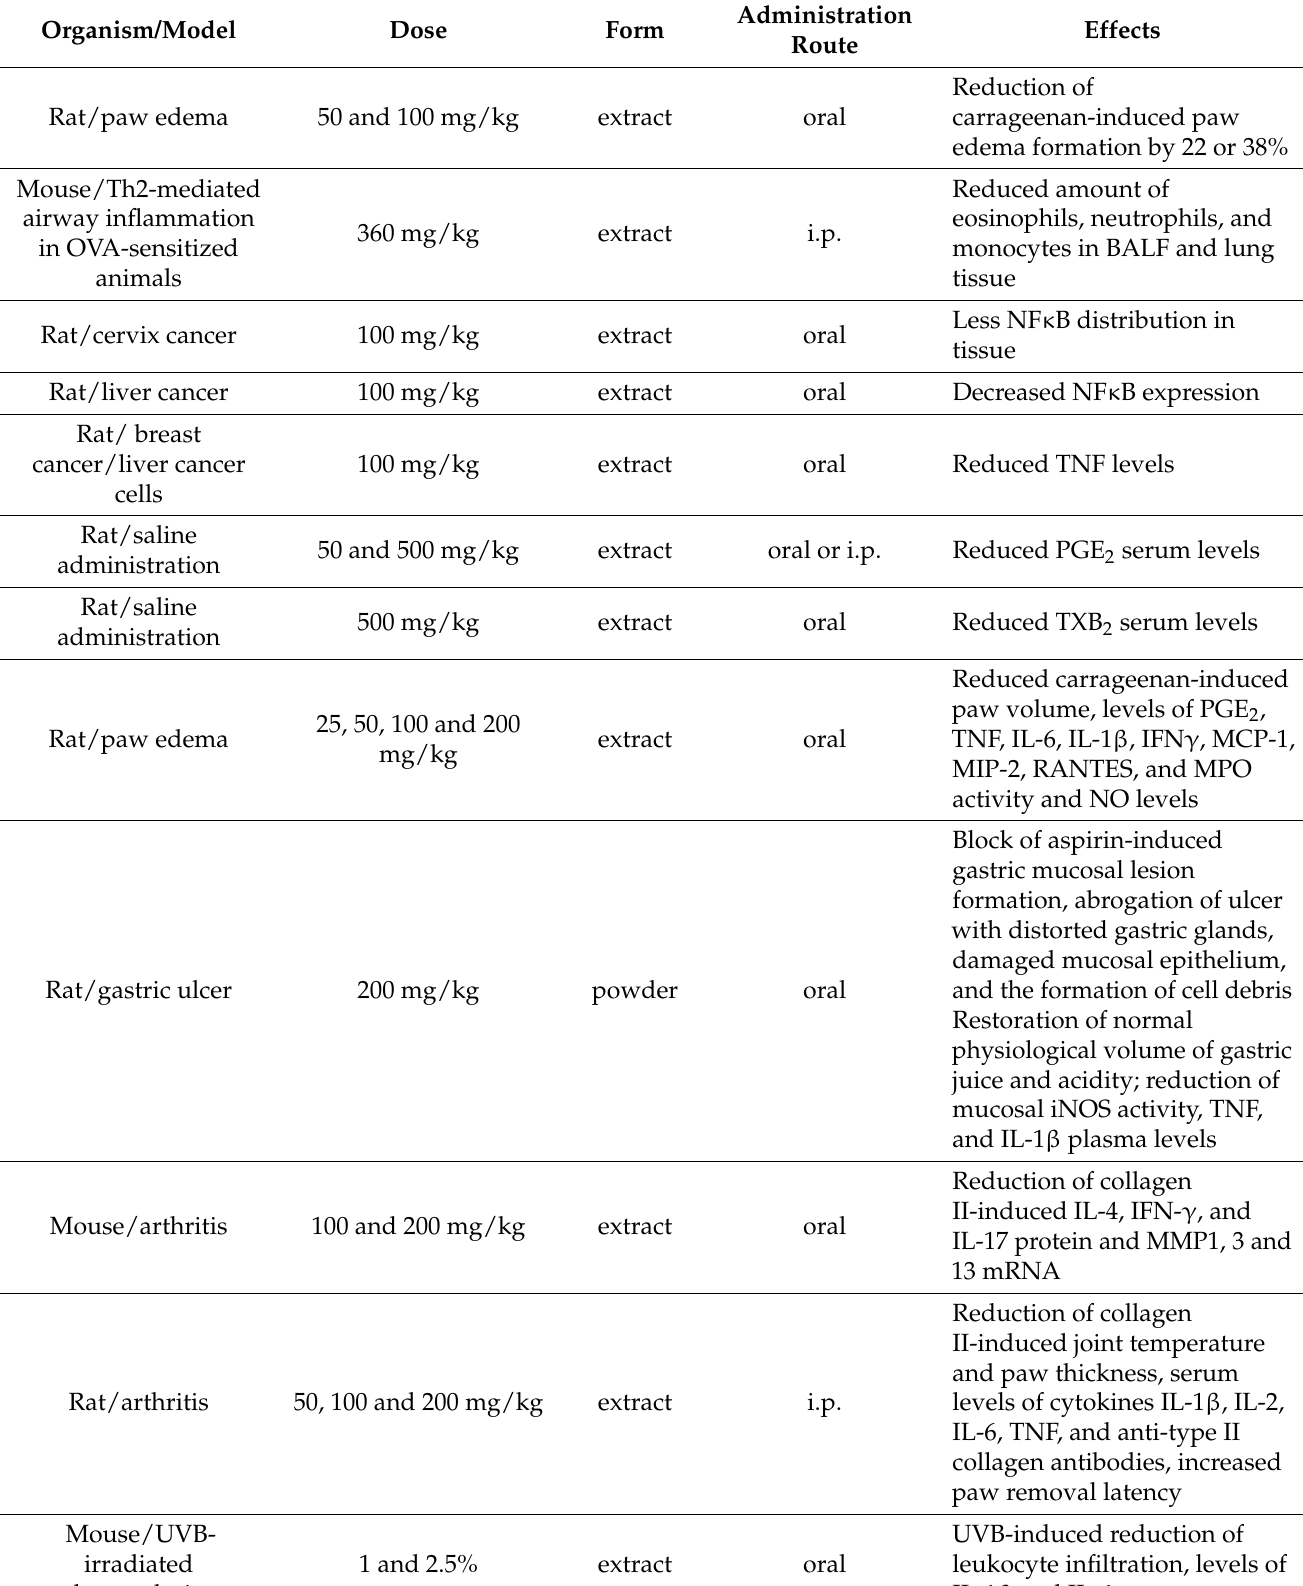
Table 1. In vivo anti-inflammatory effects of Zingiber officinale